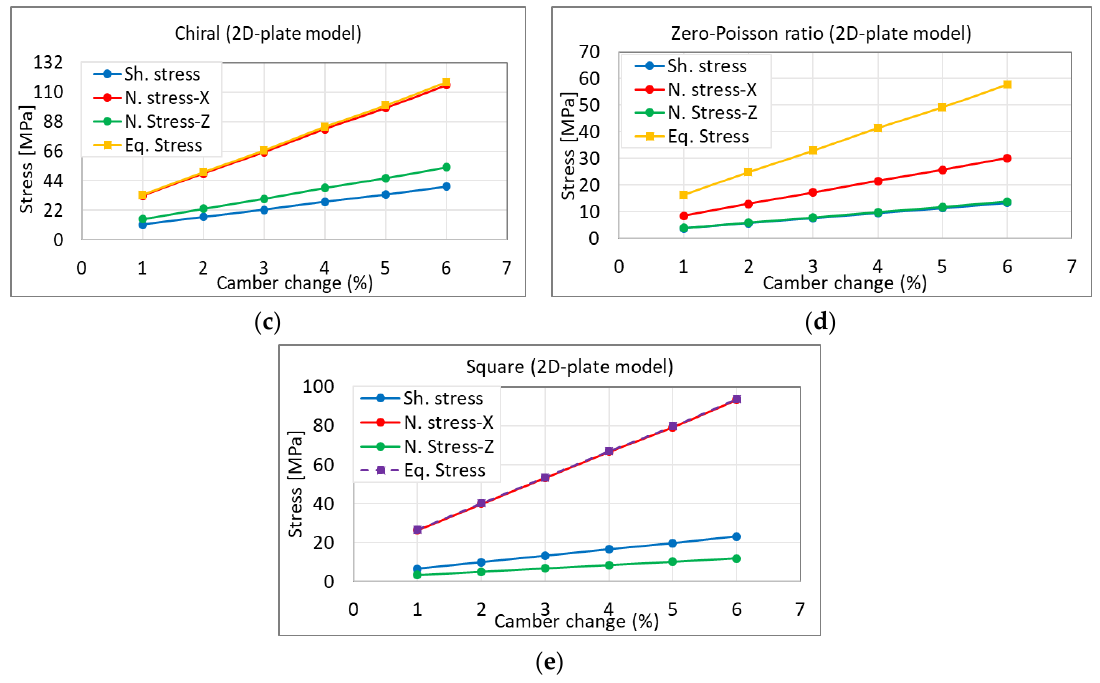
Figure 17. Stress vs. percentage of camber change ( a ) honeycomb, ( b ) auxetic, ( c ) chiral, ( d ) zero-Poisson, and ( e ) square lattice.